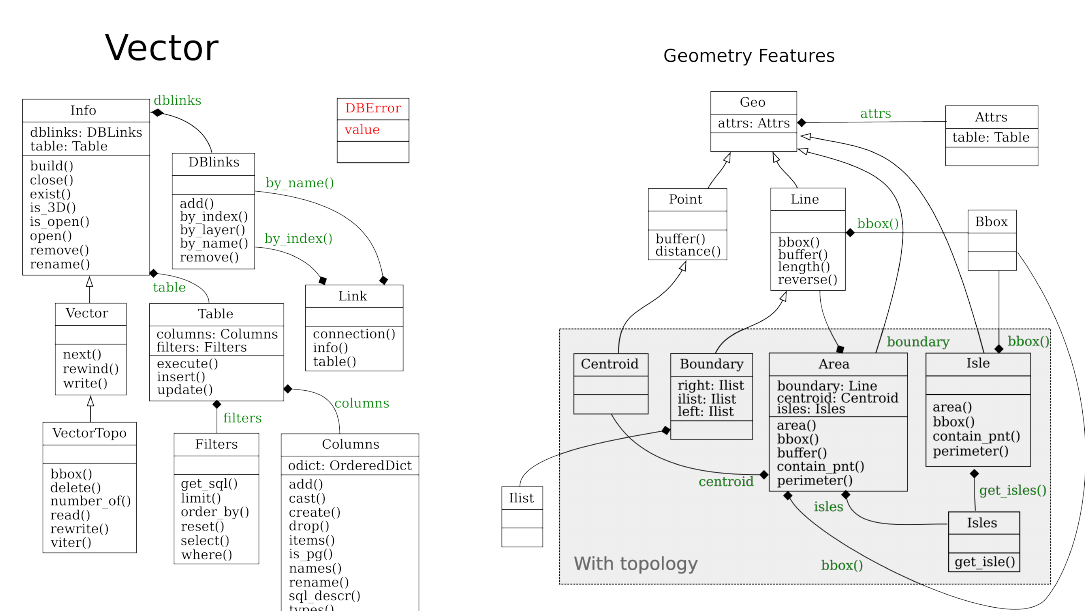
Figure 2. Vector